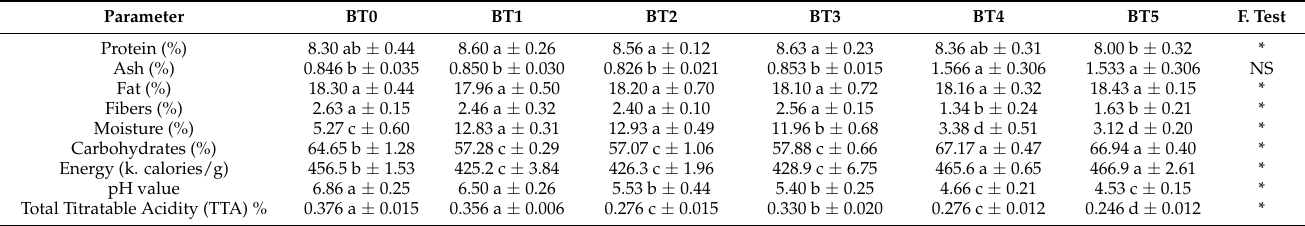
Table 2. Chemical composition of processed